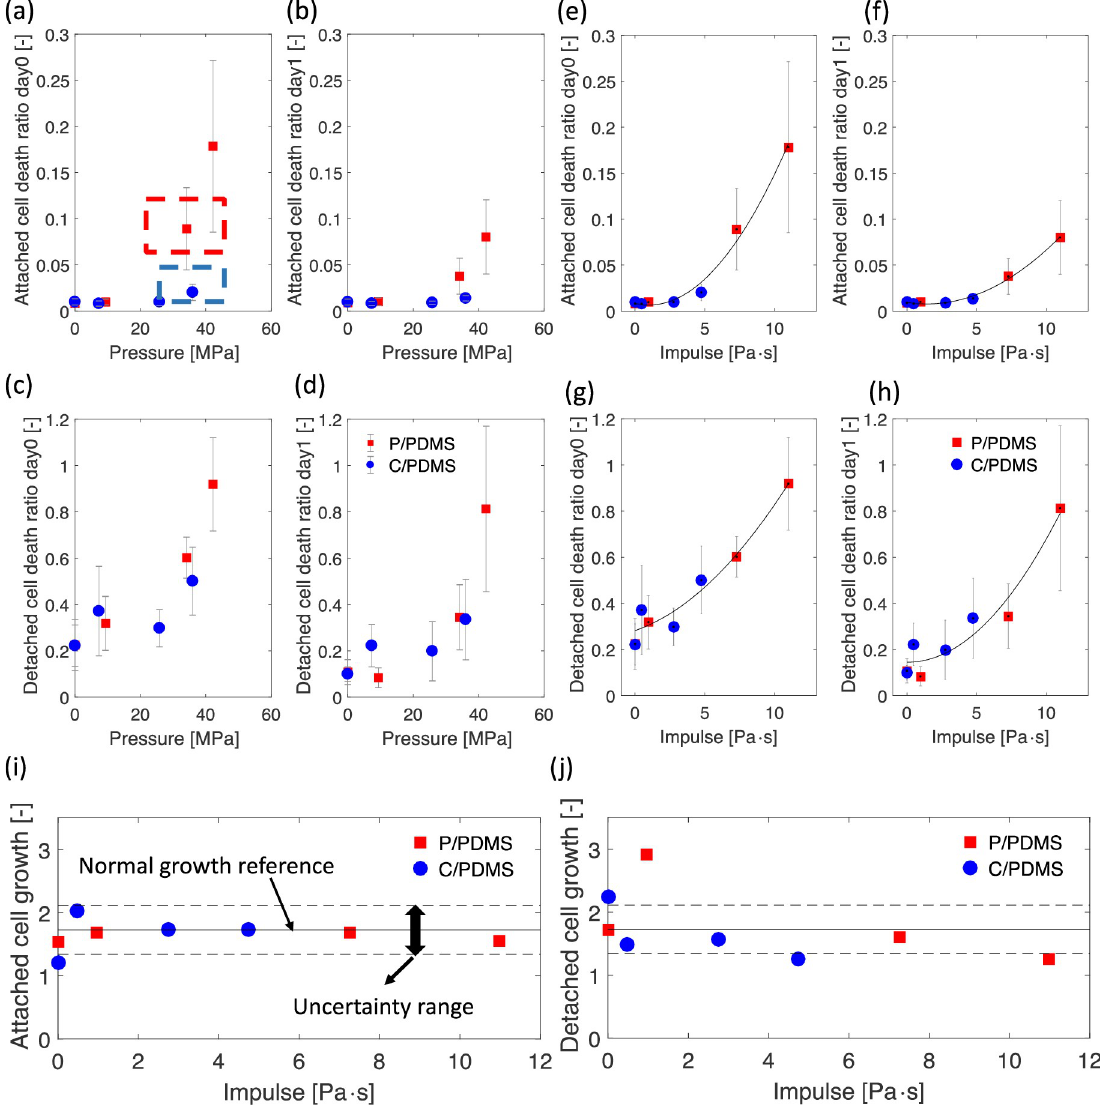
Fig 7. (a), (b), (c), and (d) Cell death ratio versus the pressure from imaging results for both P/PDMS and C/PDMS coatings. (a) Cell death ratio among attached cells on day 0. (b) Cell death ratio among attached cell on day 1. (c) Cell death ratio among detached cell on day 0. (d) Cell death ratio among detached cells on day 1. (e), (f), (g), and (h) Cell death ratio versus the impulse from imaging results for both P/PDMS and C/PDMS coatings. (e) Cell death ratio among attached cells on day 0. (f) Cell death ratio among attached cell on day 1. (g) Cell death ratio among detached cell on day 0. (h) Cell death ratio among detached cells on day 1. The error bars show the standard deviations. Results are from three independent tests and four samples were test in each independent test. The black lines in the plots represent the fitted curves using second order polynomials. The control case is represented by zero impulse, i.e. no laser treatment. (i) The average growth rate of live cells among attached cells; (j) The average growth rate of live cells among detached cells; the solid line in (i) and (j) corresponds to the normal growth rate of MDA-MB-231, and the dash lines represents the according uncertainty range. The cell growth rate was the ratio of the number of live cells of the second day to that of the first day. The uncertainty of the cell growth was calculated using the standard deviations of the cell doubling time given by Limame et al.